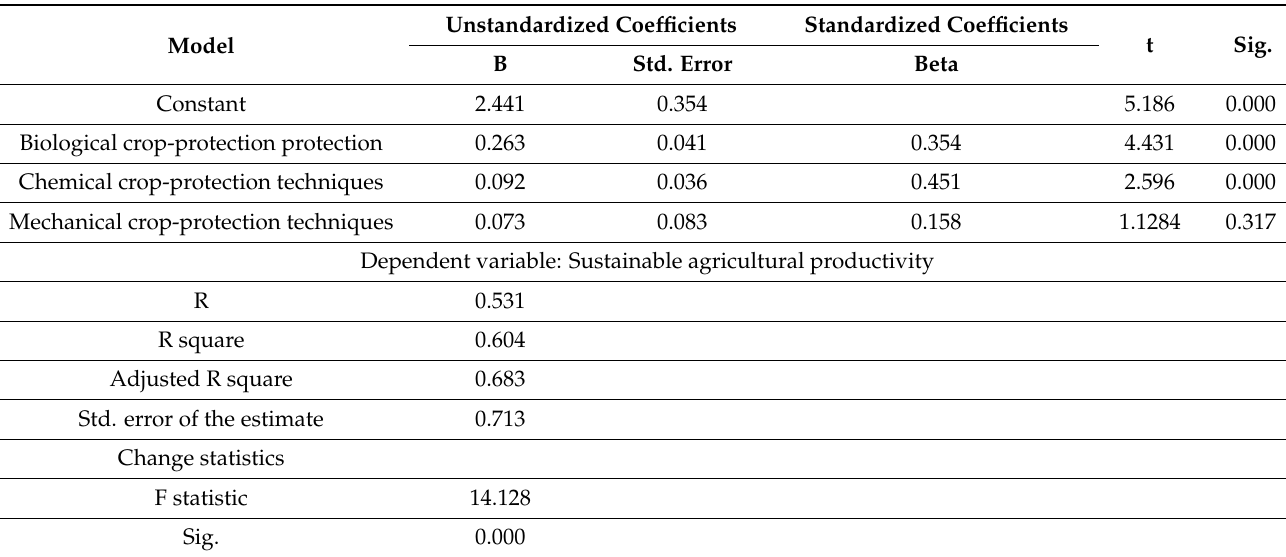
Table 8. Regression analysis.